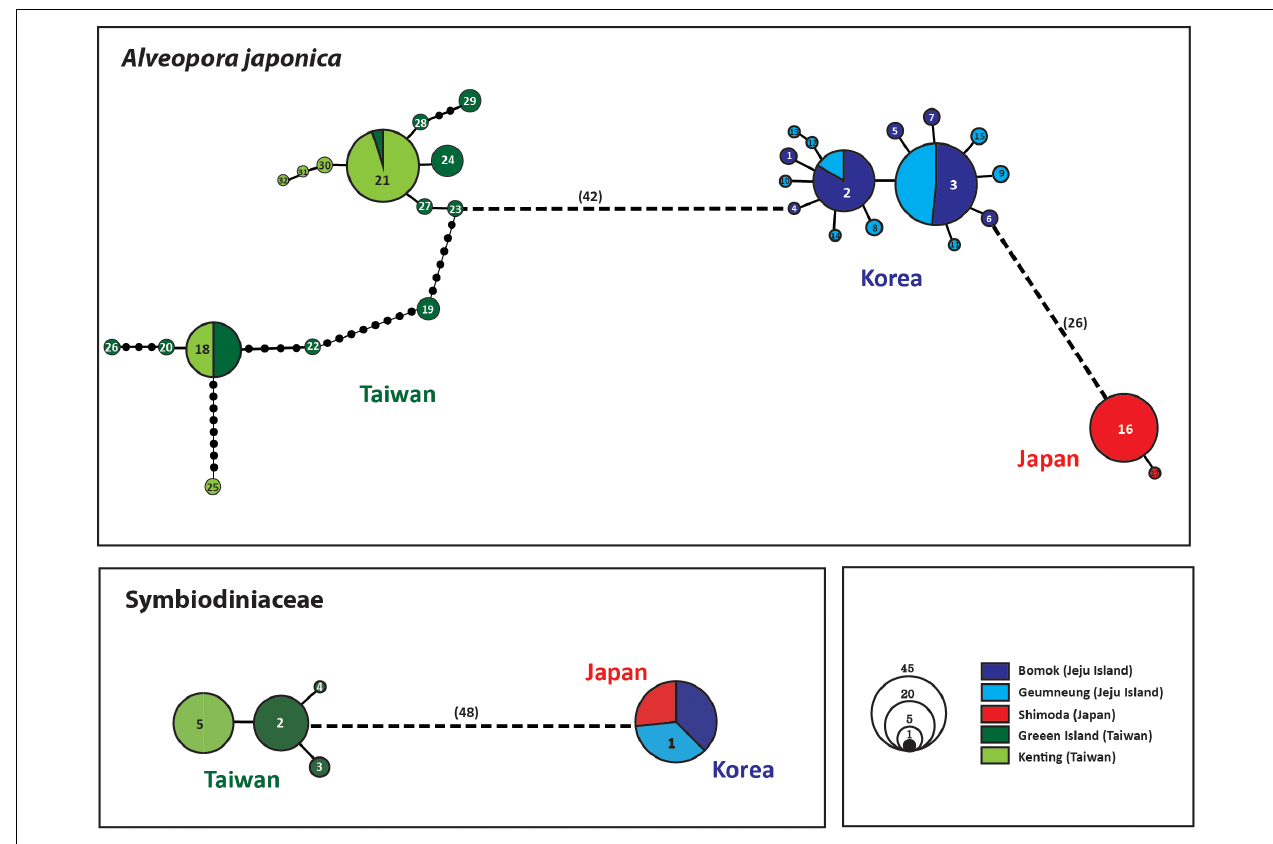
FIGURE 4 | Statistical parsimony haplotype network of ITS haplotypes of A. japonica and 23S rDNA of Symbiodiniaceae. The area of the circle is proportional to the individual numbers found for the respective haplotype; numbers shown inside a circle represent haplotype numbers; each line in the network represents a single mutational step between haplotypes irrespective of its length (unless indicated otherwise). Different colors denote the geographic